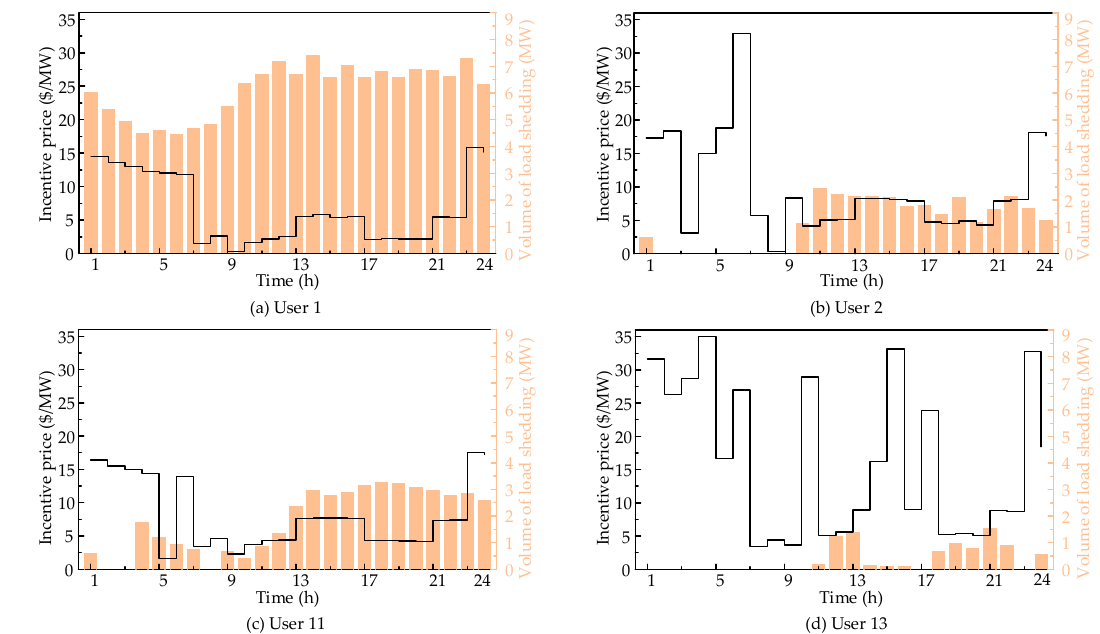
Figure 5. Optimal individualized incentive prices and corresponding volume of load shedding over a 24-h period for users 1, 2, 11 and 13.